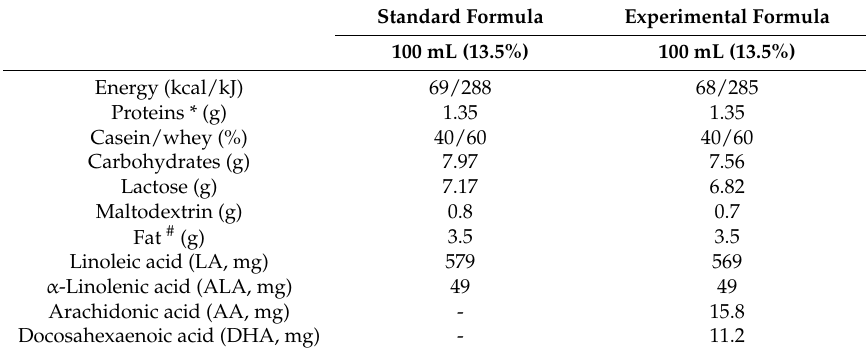
Table 1. Standard and Experimental Infant Formula Nutrition Facts per 100 mL.